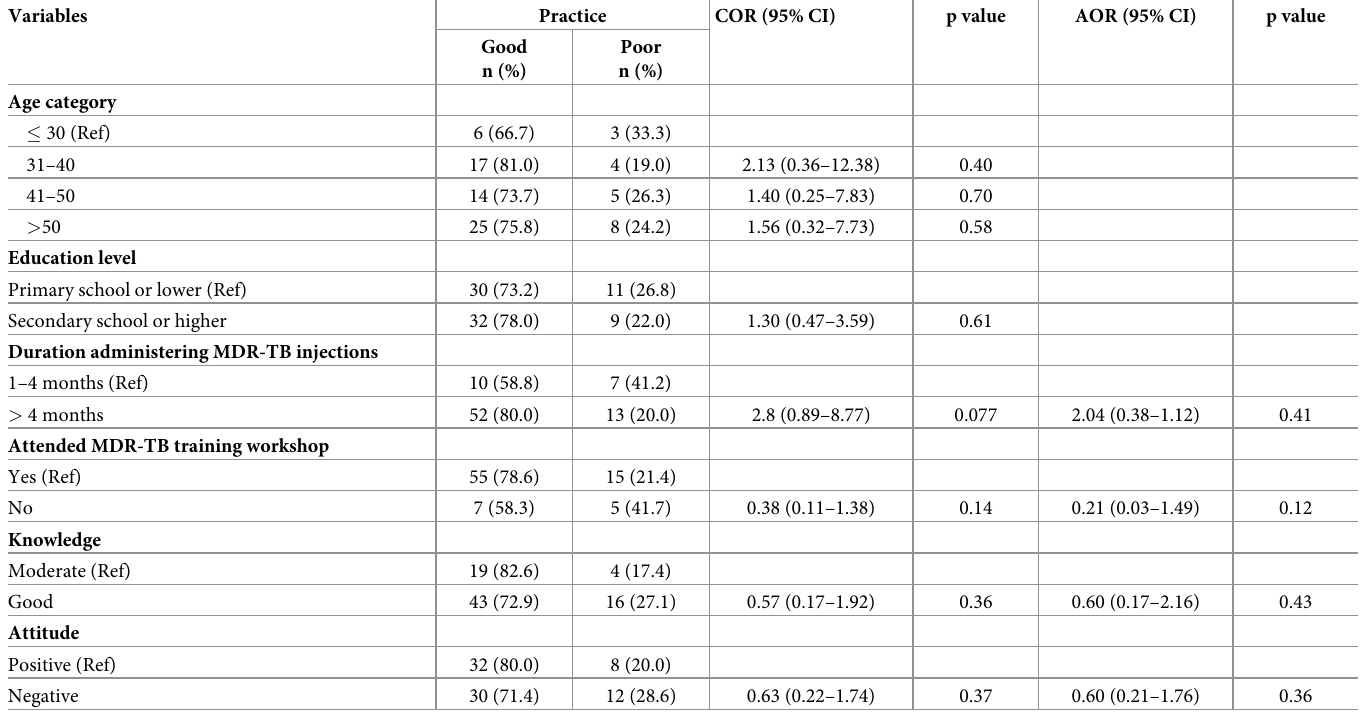
Table 6. Bivariate and binomial logistic regression predicting community based MDR-TB management practice among CTSs.